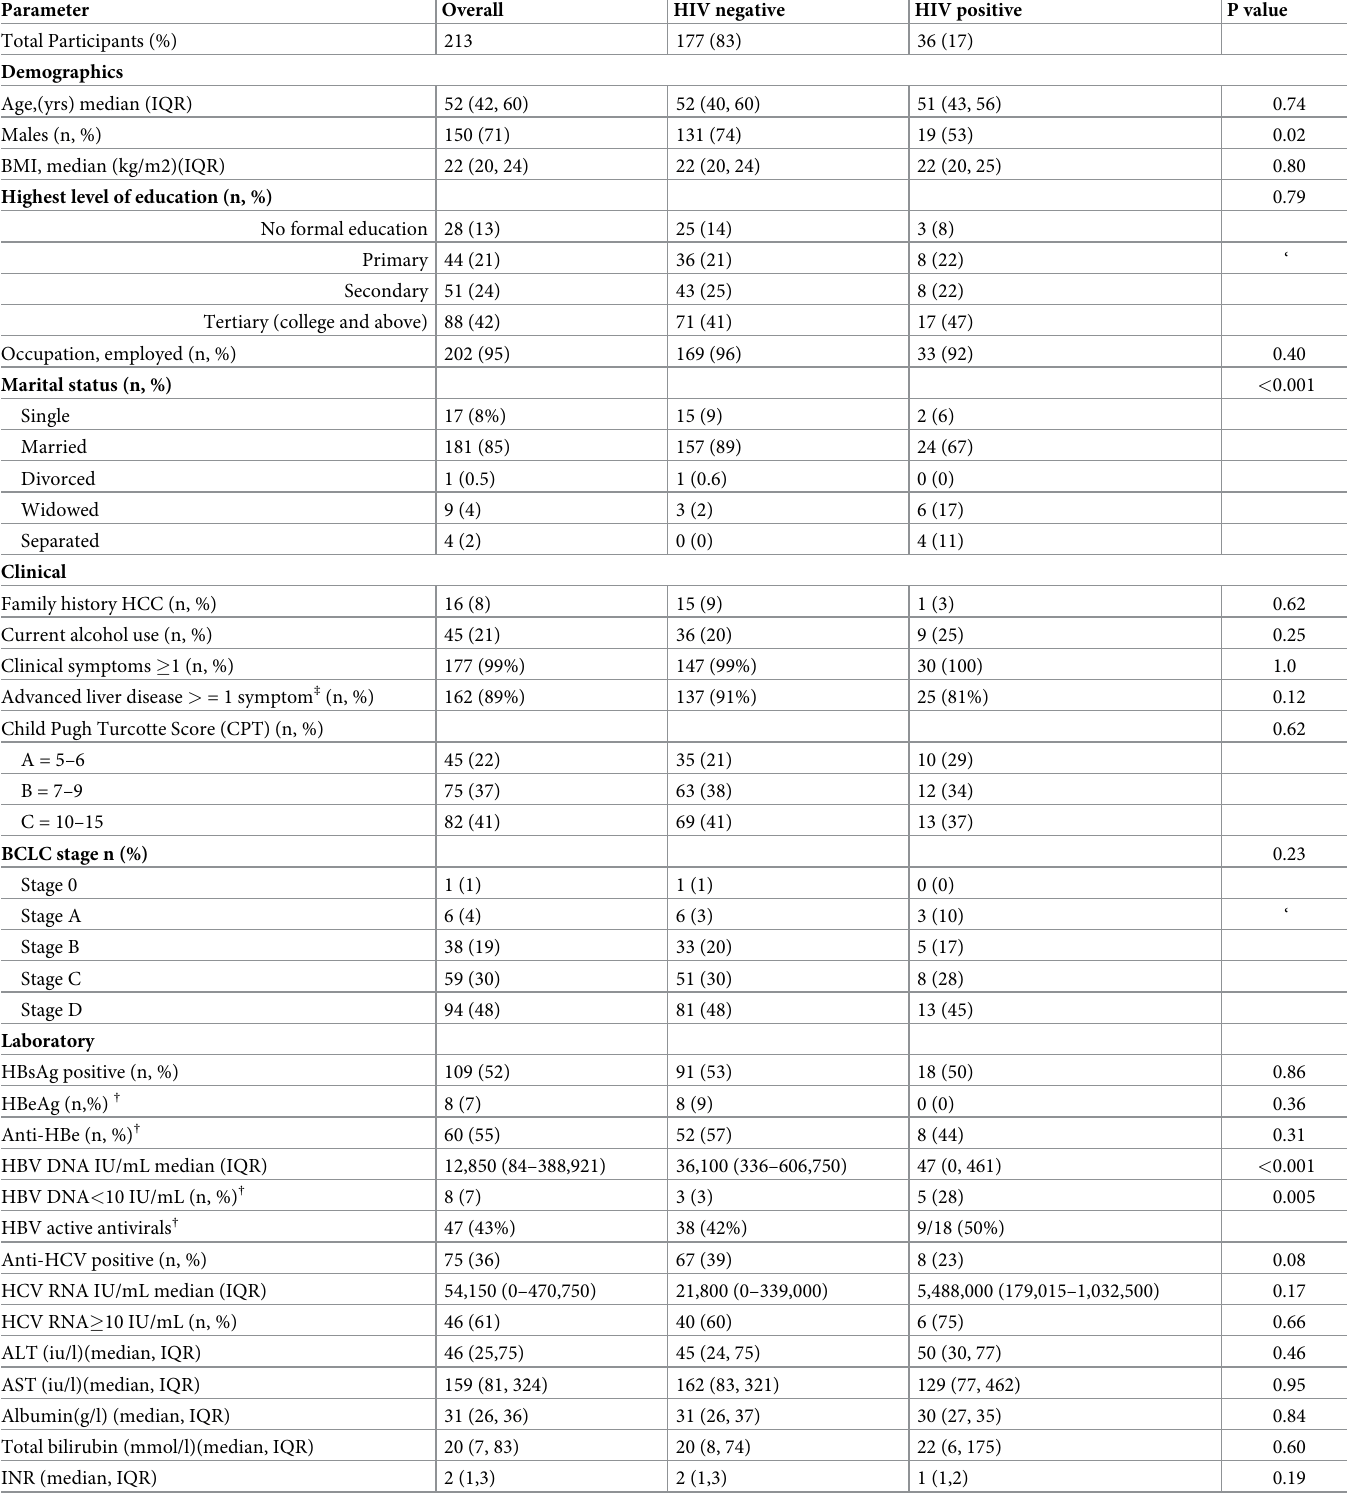
Table 1. Characteristics of HCC study participants by HIV status at study